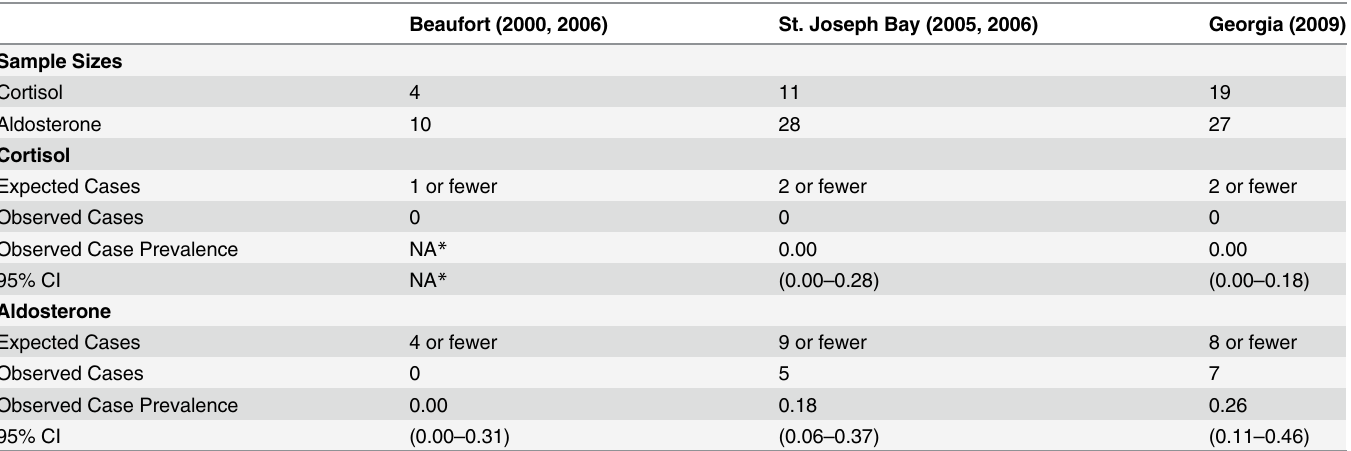
Table 4. Reference Interval